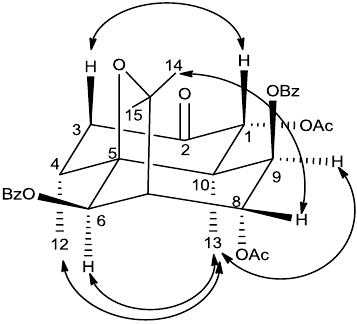
Figure 2. NOESY experiment of compound 2